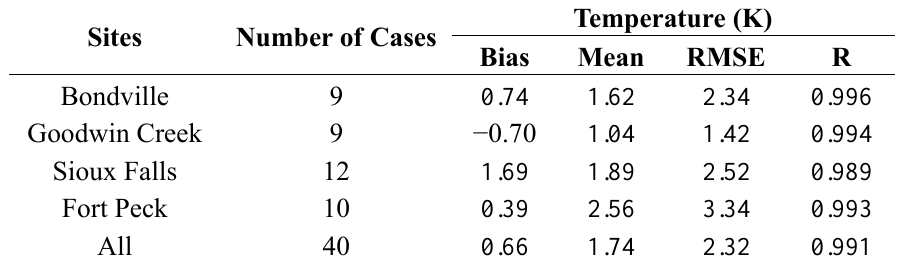
Figure 8. The comparison scatterplots of LST from Landsat-8 TIRS data and the LST from ground-based measurements at four SURFRAD sites. Data used here are from 2013 to 2014. Table 7. Summaries of the validation results according to different ground sites. Bias, Mean, RMSE and R have the same meaning as Table